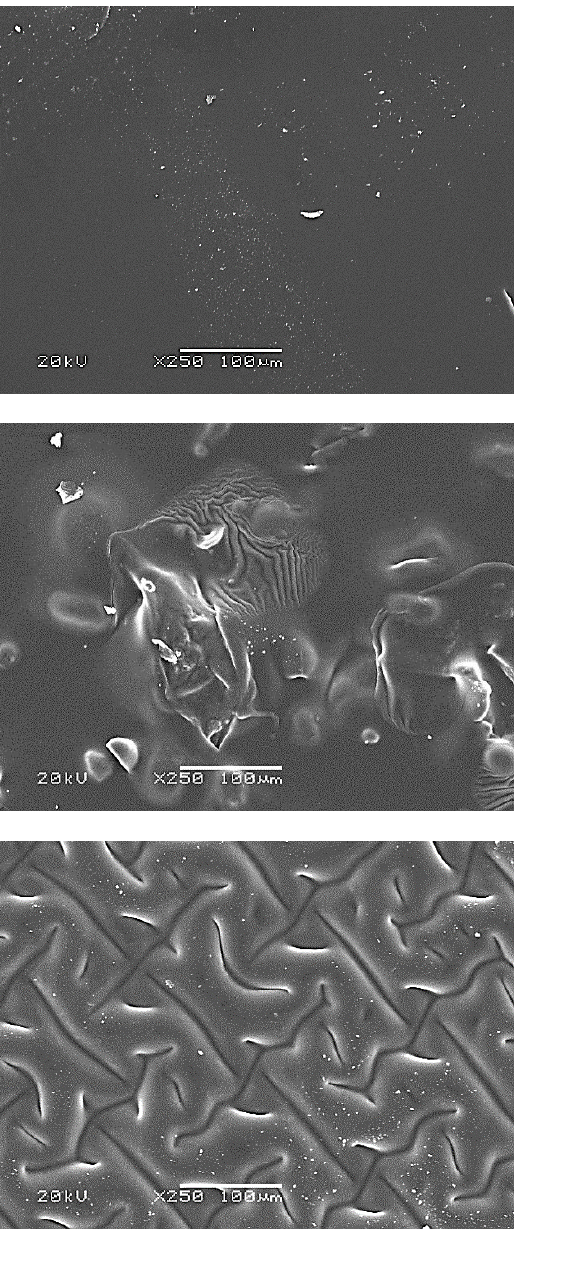
Figure 10. SEM images of hydrogel samples: 20/10 ( a ), 20/10/5 ( b ) and 20/10/5 (T) ( c ) (the analysis was performed using two magnifications: ×250 and ×500).